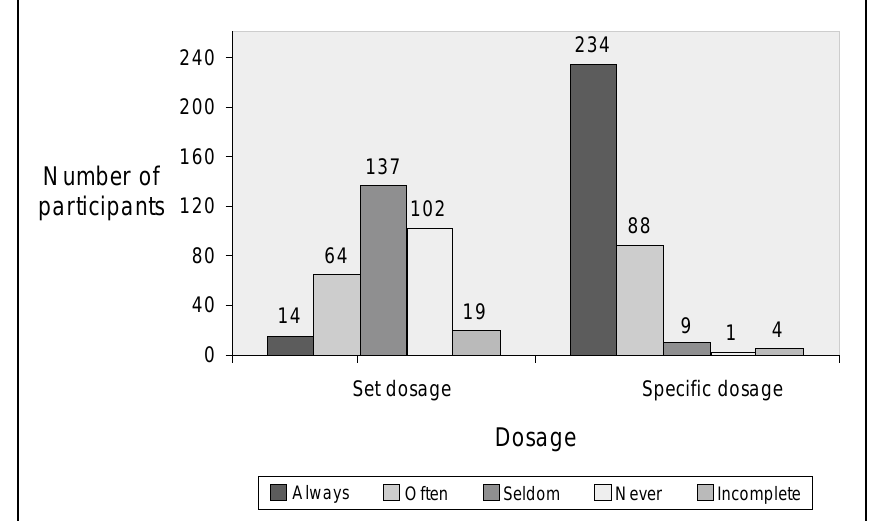
Figure 5: Nature of exercise therapy